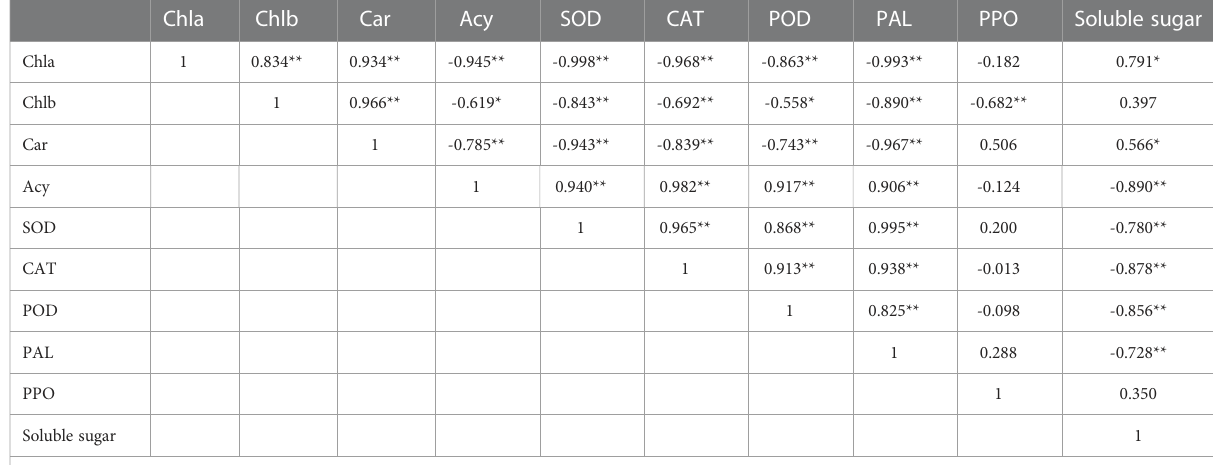
TABLE 1 Correlation analysis of the leaf biochemical indexes of A. p. subsp. mono